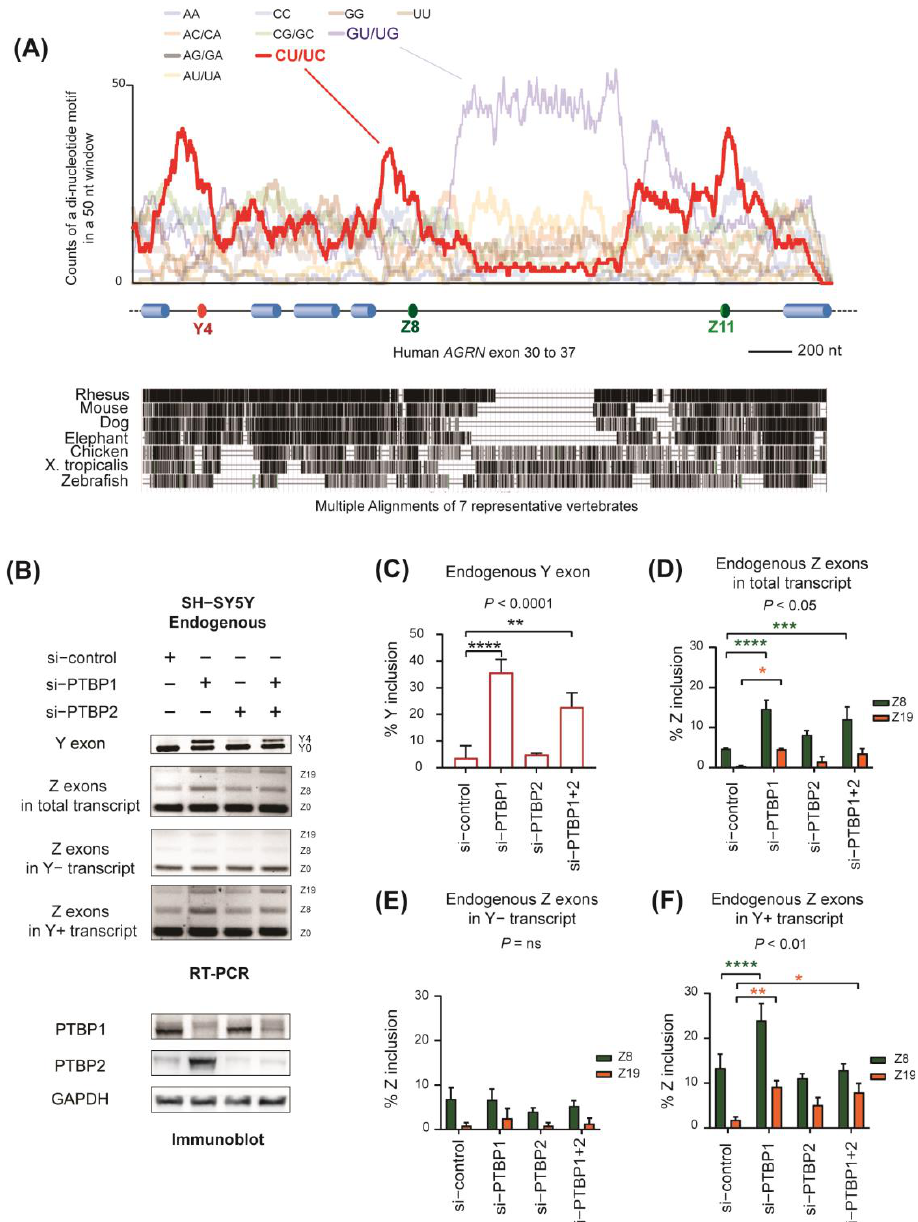
Figure 2. PTBP1 represses splicing of Y and Z exons. ( A ) ( Upper panel ) Enrichment of di − nucleotide motifs in human AGRN exons 30 to 37. The count of each di − nucleotide motif in a 50 nt window (vertical axis) at the indicated position of AGRN (horizontal axis) is shown. ( Bottom panel ) Alignment of genomic segments of 7 representative vertebrates to human AGRN exons 30 to 37, which were extracted from “Multiple alignments of 100 vertebrate species” in the UCSC genome browser. Pairwise alignments of each species to the human genome (hg38) are shown as a gray − scale density plot, with darker values indicating higher alignment quality. ( B ) RT − PCR showing alternative splicing of endogenous Y and Z exons in SH − SY5Y cells treated with indicated siRNAs. Immunoblotting ( bottom panel ) confirmed the downregulation of PTBP1 and PTBP2. ( C – F ) Quantification of ( B ). Mean and SD ( n = 3 independent experiments) of %Y inclusion and %Z inclusion are indicated. p − values of one − way ANOVA ( C ) and two − way ANOVA ( D – F ) are indicated above the graph. * p < 0.05, ** p < 0.01, *** p < 0.001, and **** p < 0.0001 using Tukey’s post hoc test compared to si − control when